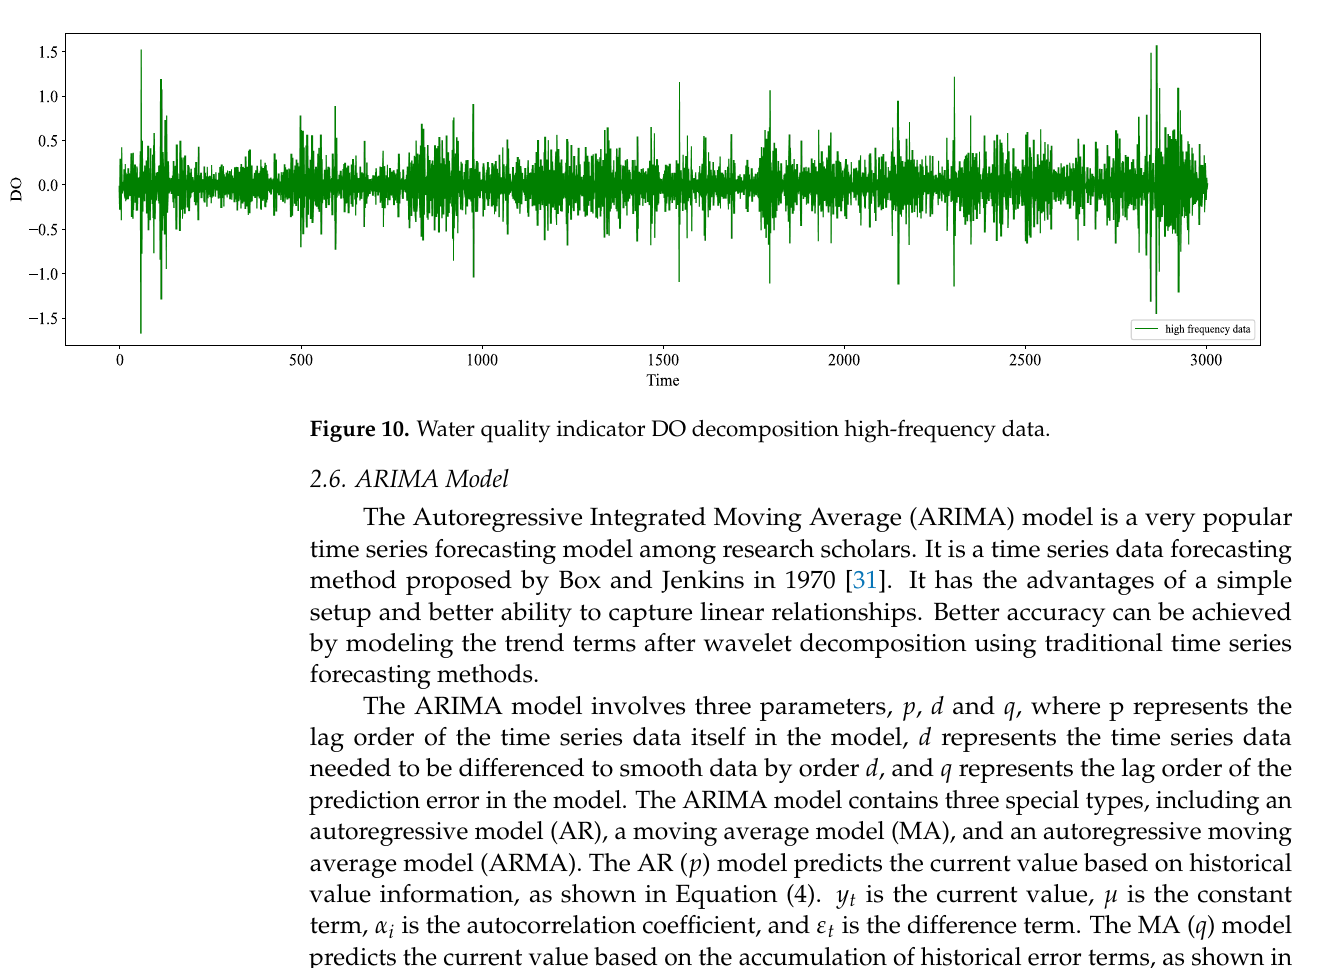
Figure 9. Water quality indicator DO decomposition low-frequency data.